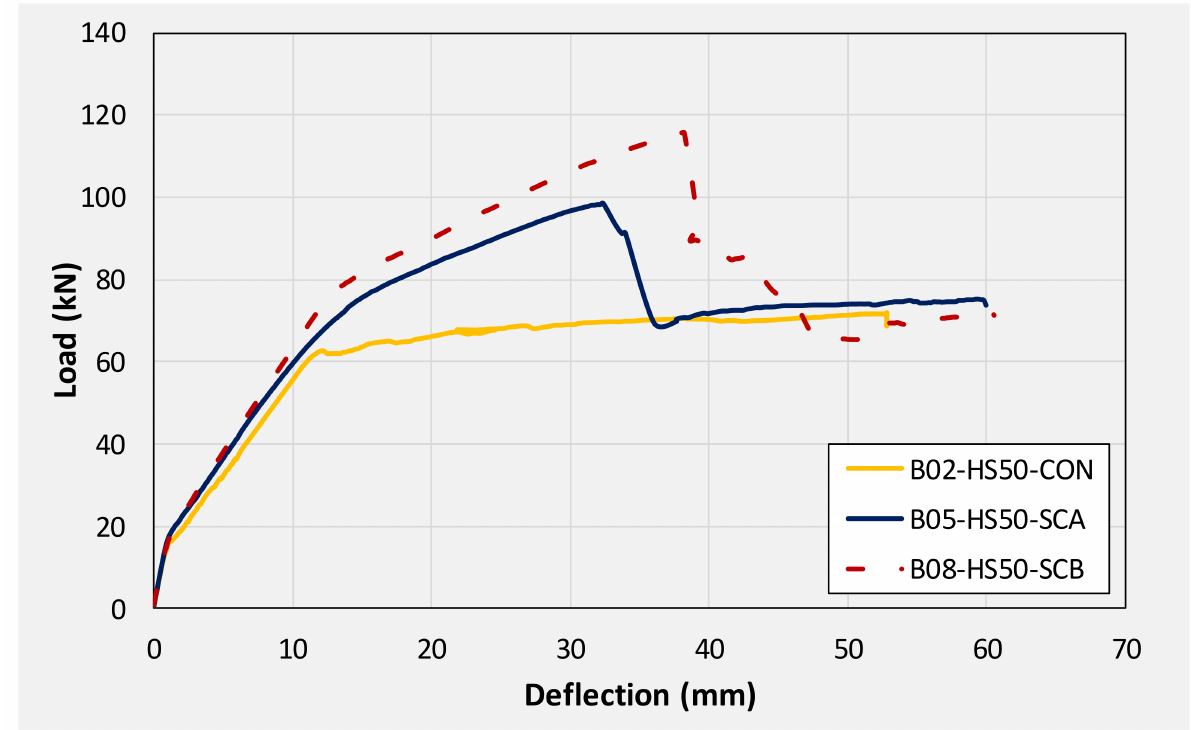
Figure 18. Comparison of load-deflection curves of beams with 50 mm square